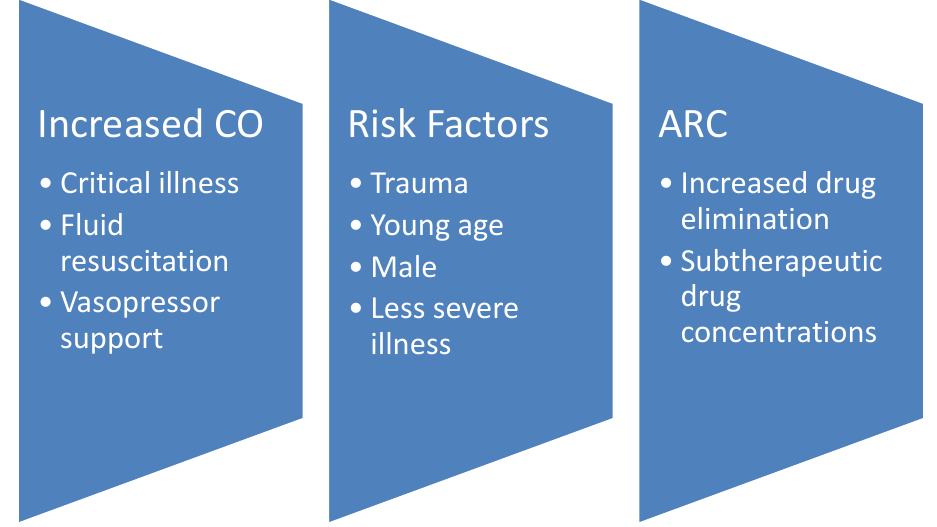
Figure 1. The development of augmented renal clearance (ARC); cardiac output, CO.